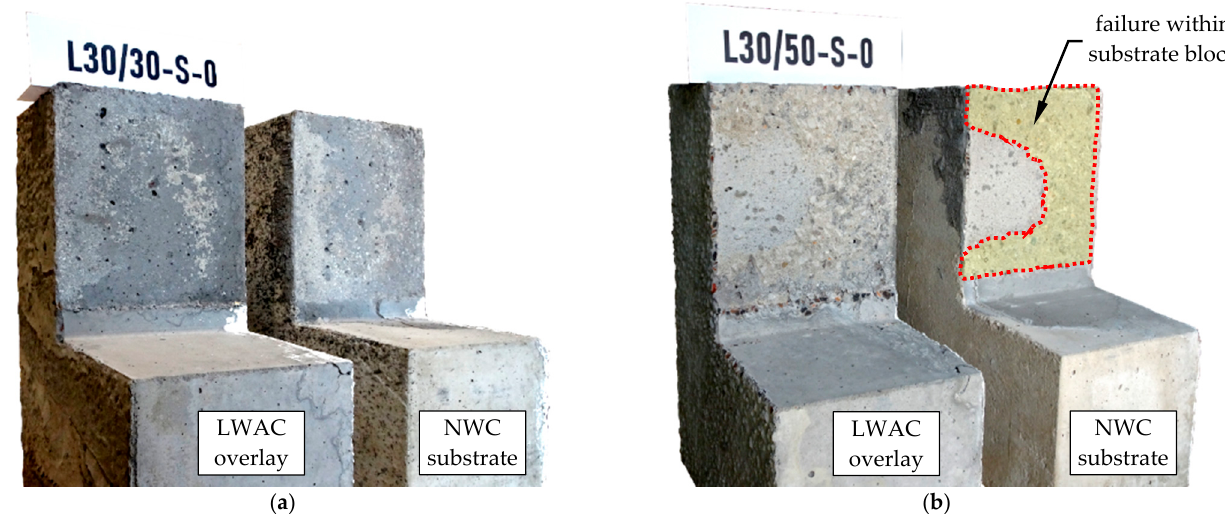
Figure 14. View of the test specimens with smooth interface after failure: ( a ) L30/30-S-0, ( b ) L30/50-S-0.